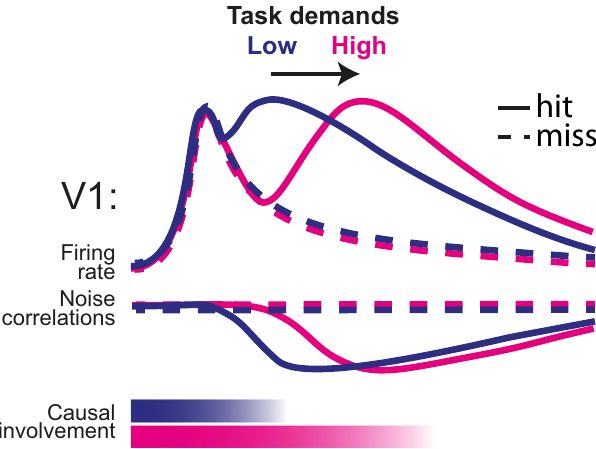
Fig. 8 Schematic summary of results. Increased task demands (in our tasks imposed by multisensory requirements) delay the onset of the late report-related wave of activity and drop in noise correlations, and extend the causal involvement of V1. Jointly, these processes predict the behavioral effect of late V1 inactivation on visual detection, and whether a trial is going to be a hit or a